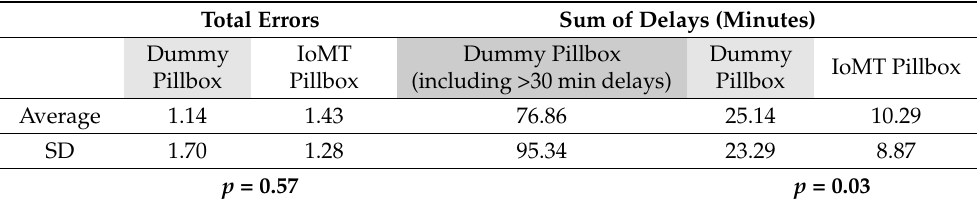
Table 2. Comparison of Errors and Dose Delays between Dummy and IoMT Pillbox